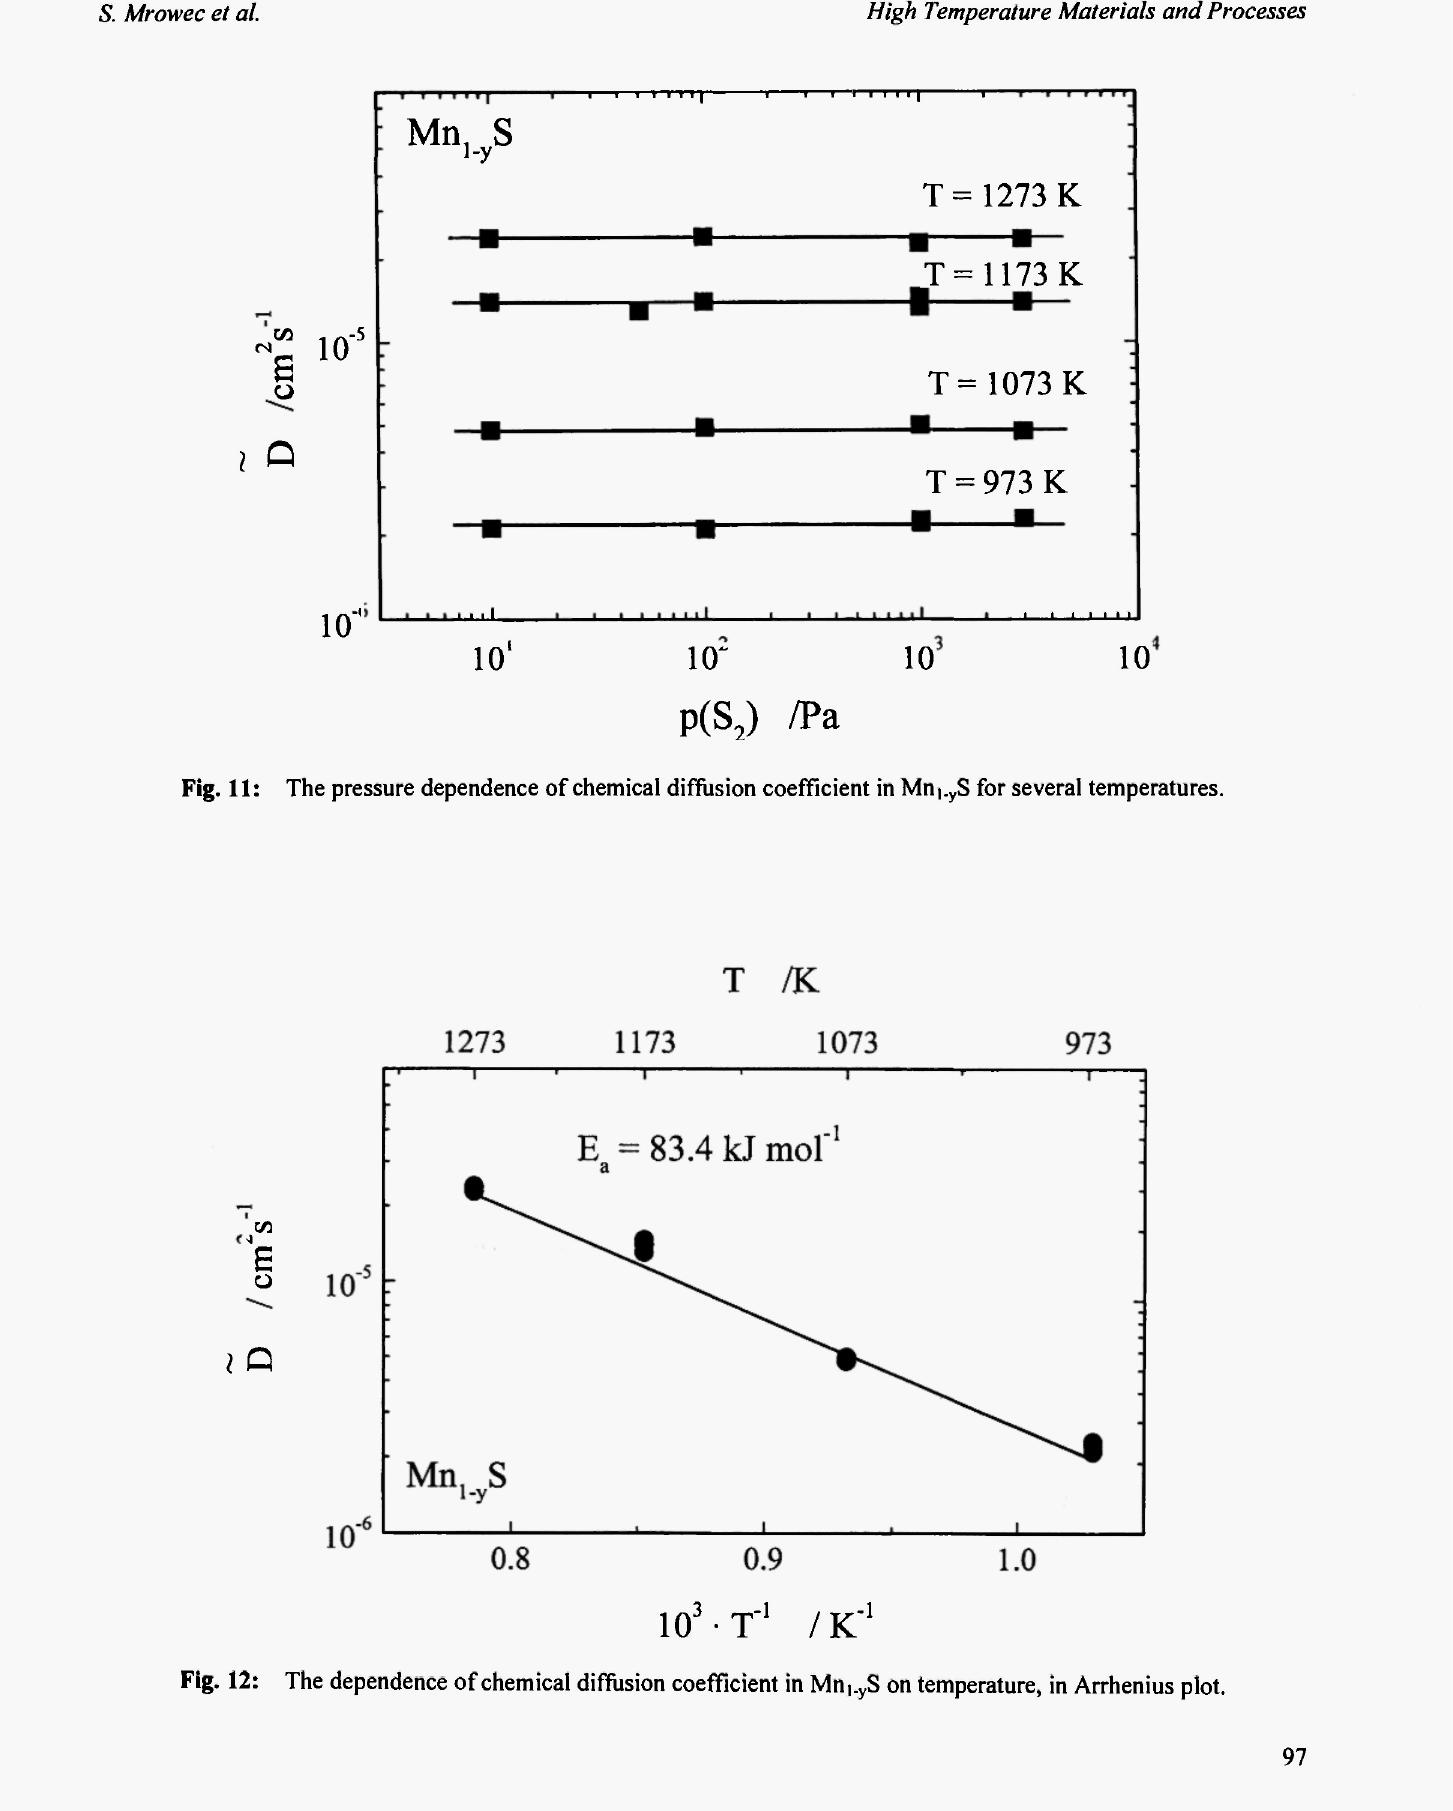
The dependence of chemical diffusion coefficient in Mn,. y S on temperature, in Arrhenius